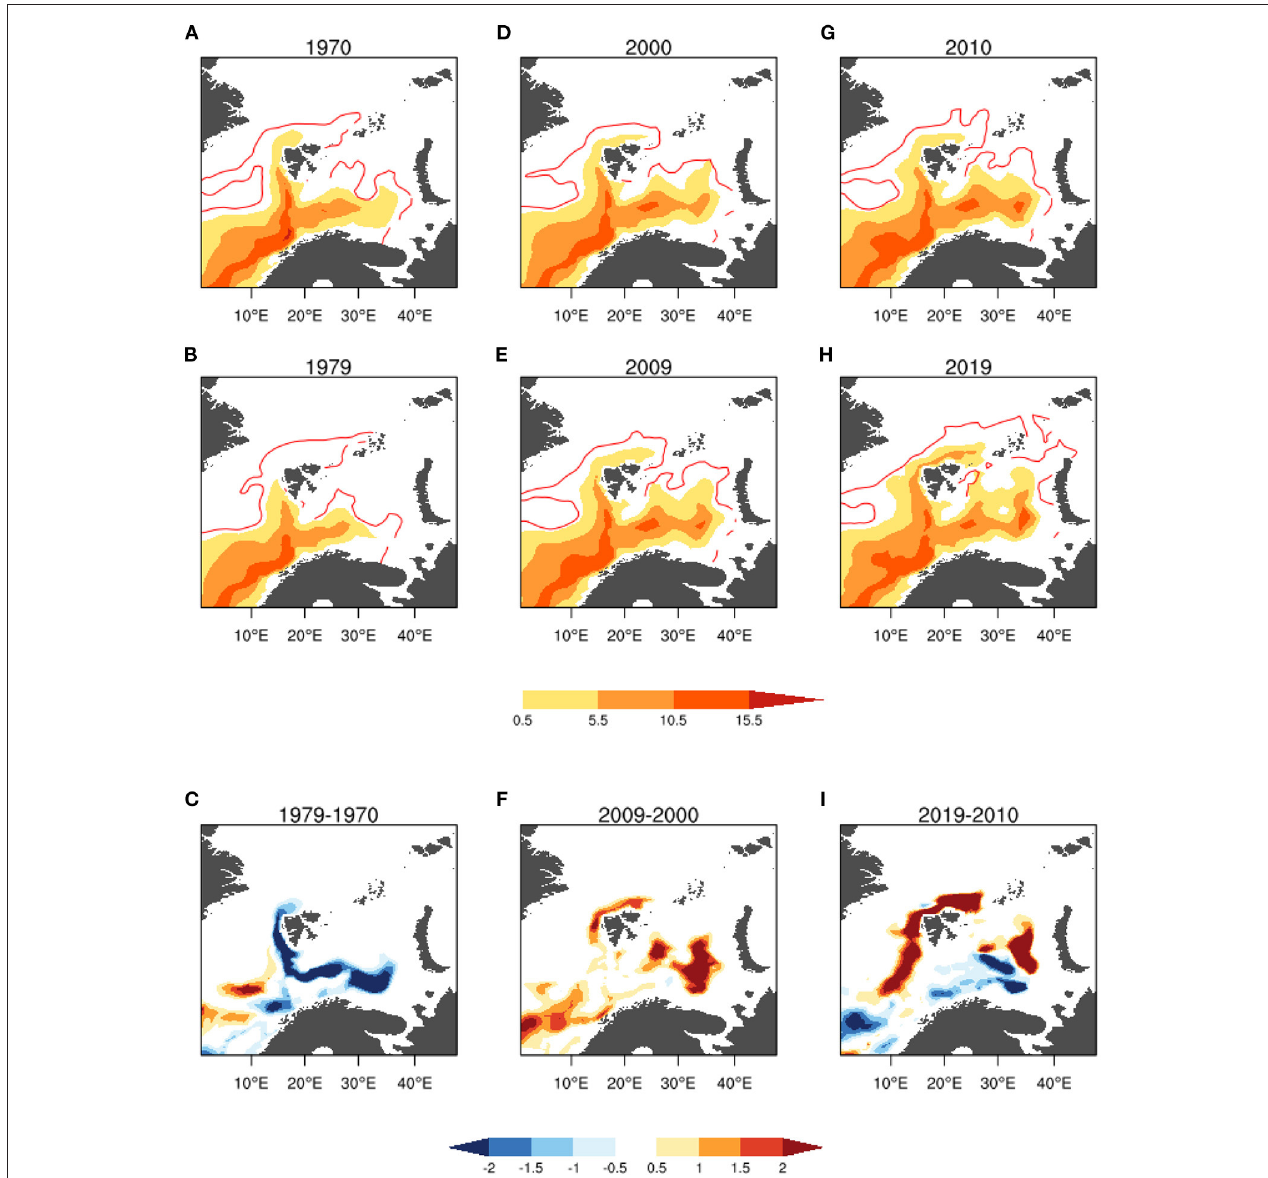
FIGURE 6 | Mean volume of Atlantic Water (x10 2 Km 3 ) at each grid point from the assimilation experiment over three years centered on (A) 1970, (B) 1979, their difference (C) 1979–1970, (D) 2000, (E) 2009 and their difference (F) 2009–2000. Since the model experiment ends at 2019, the Atlantic Water volume is shown for individual years (G) 2010, (H) 2019 and their difference (I) 2019–2010. The red contour line is the 1 ◦ C isotherm at 182 meters model